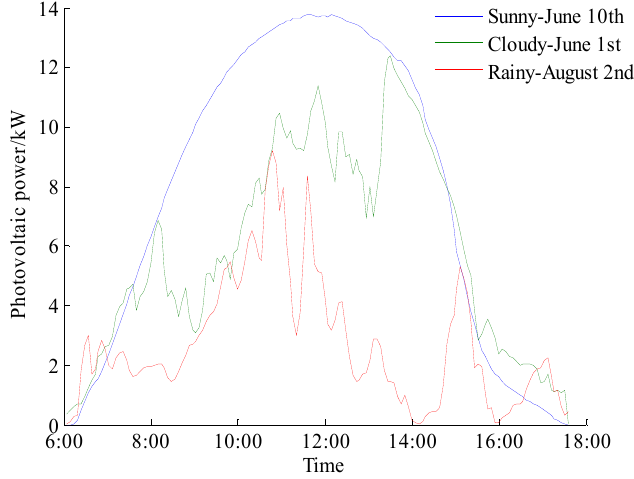
Figure 1. Photovoltaic (PV) power curves.